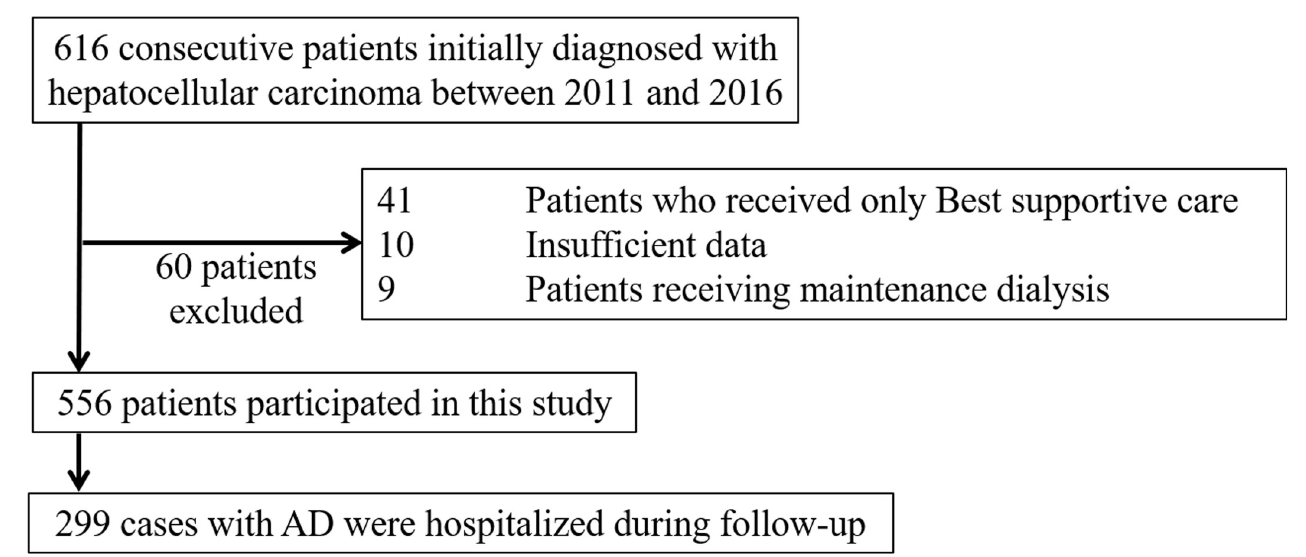
Fig 1. Protocol diagram.